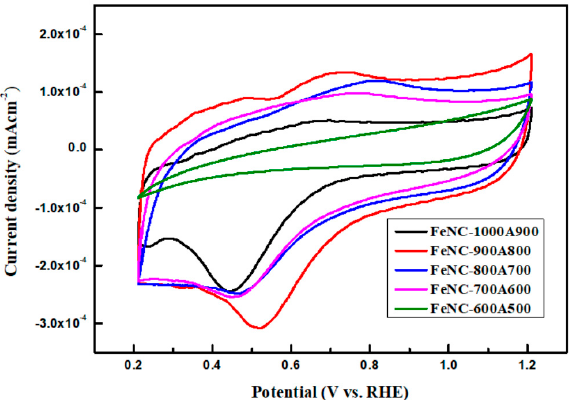
Figure 9. CV curves of FeNCs prepared with different calcination methods.